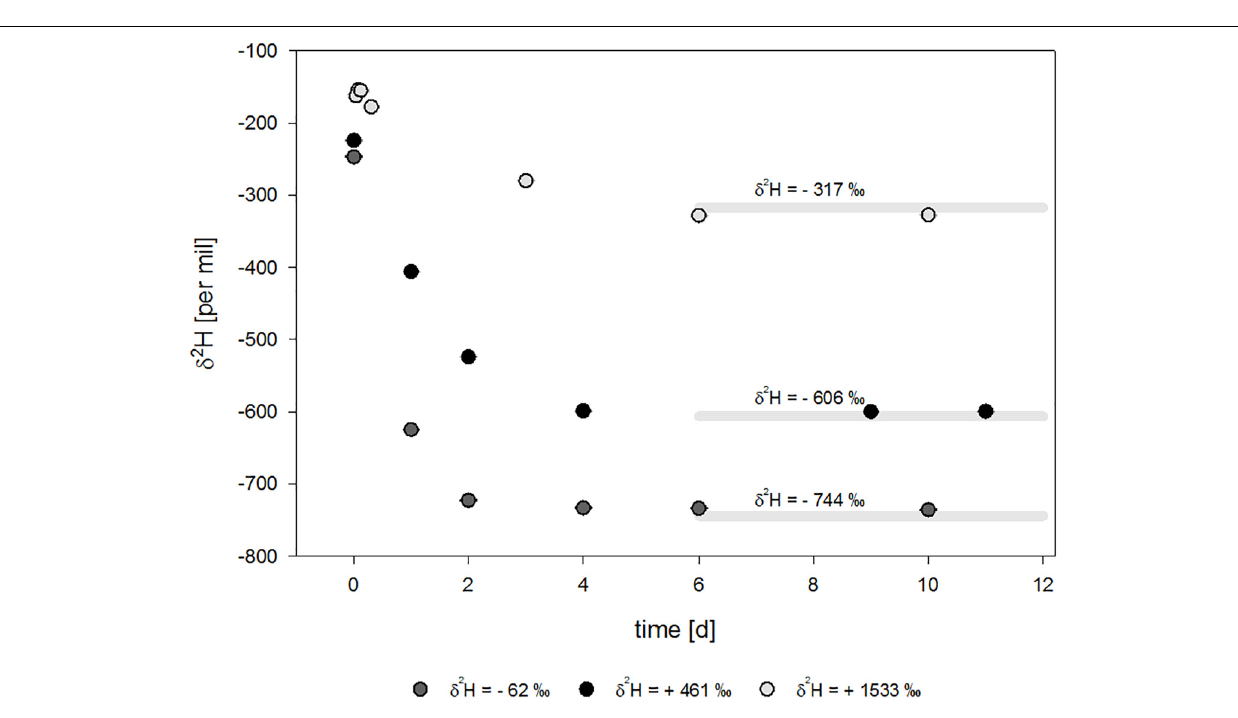
FIGURE 4 | Isotope signature over time for molybdate-inhibited setups with water of different isotope composition. Theoretical equilibrium values ± approx. 5